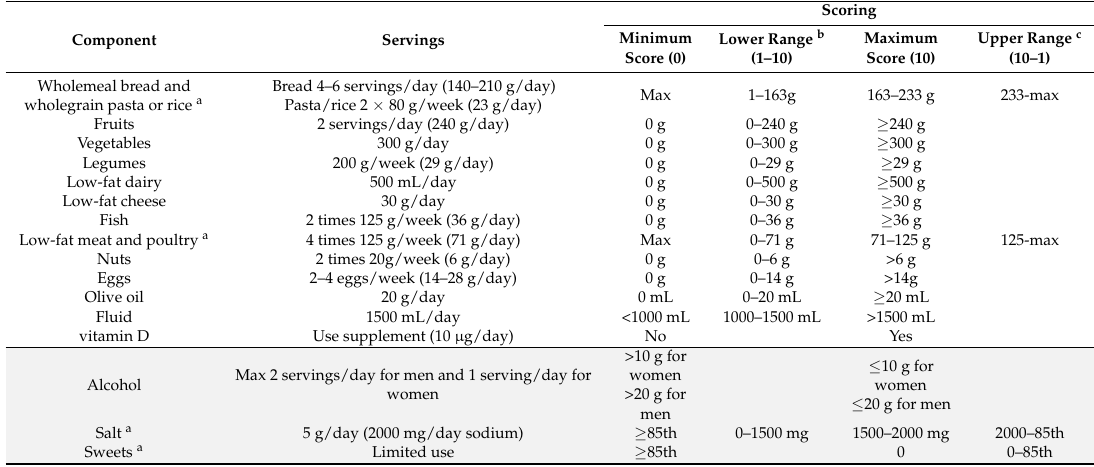
Table 1. Scoring criteria of the NU-AGE components based on NU-AGE Food Based Dietary Guidelines (FBDGs). Component